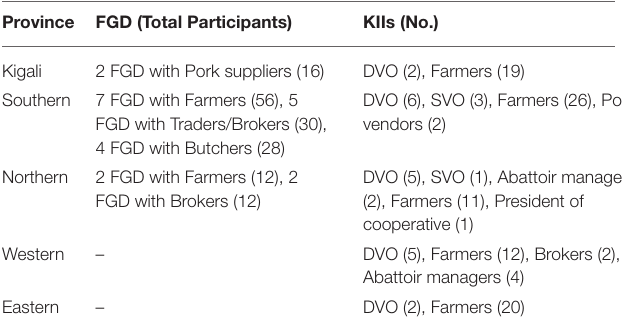
TABLE 1 | Number of focus group discussions (FGD) and key informant interviews (KII) carried out and number of participants in each. Province FGD (Total